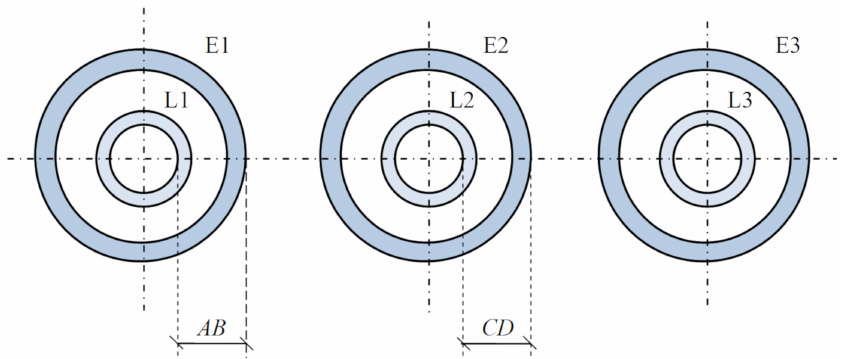
Figure 7. High-current busduct with marked segments AB and CD.